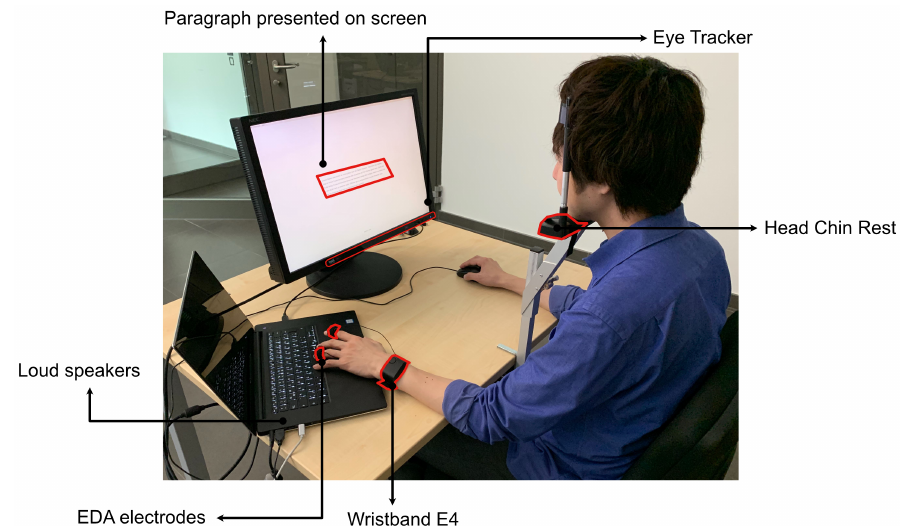
Figure 1. A participant performing the reading task. We collected eye movements using an eye-tracker Tobii 4C, EDA using a wristband Empatica E4, as well as occurrences of mind wandering through